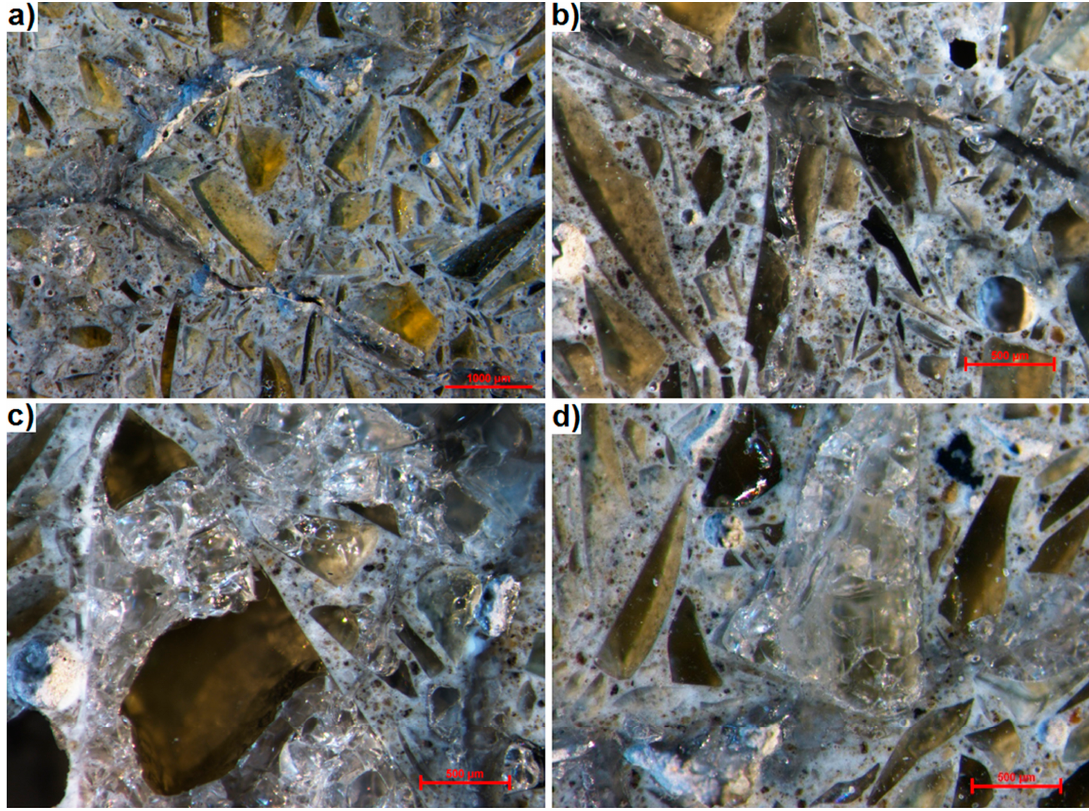
Figure 4. Polished section of mortar containing waste glass, obtained from reflected light microscopy, at ( a ) 20×; and ( b ), ( c ), ( d ) 40× magnification.